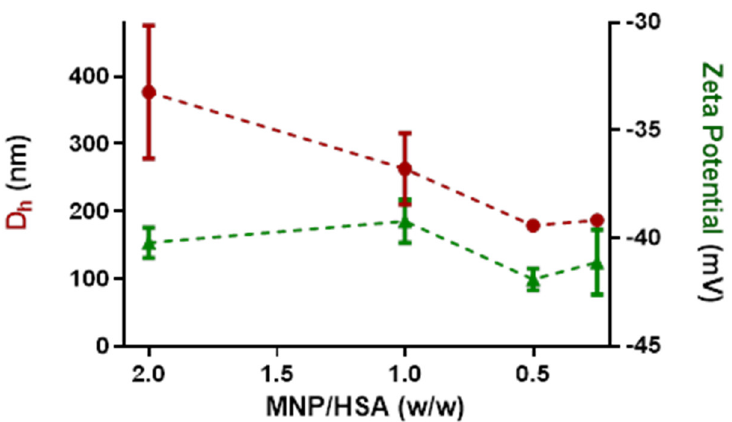
Figure 3. Titration of PP-MNPs with HSA in water. Red points: hydrodynamic diameter. Green triangles: zeta potential.